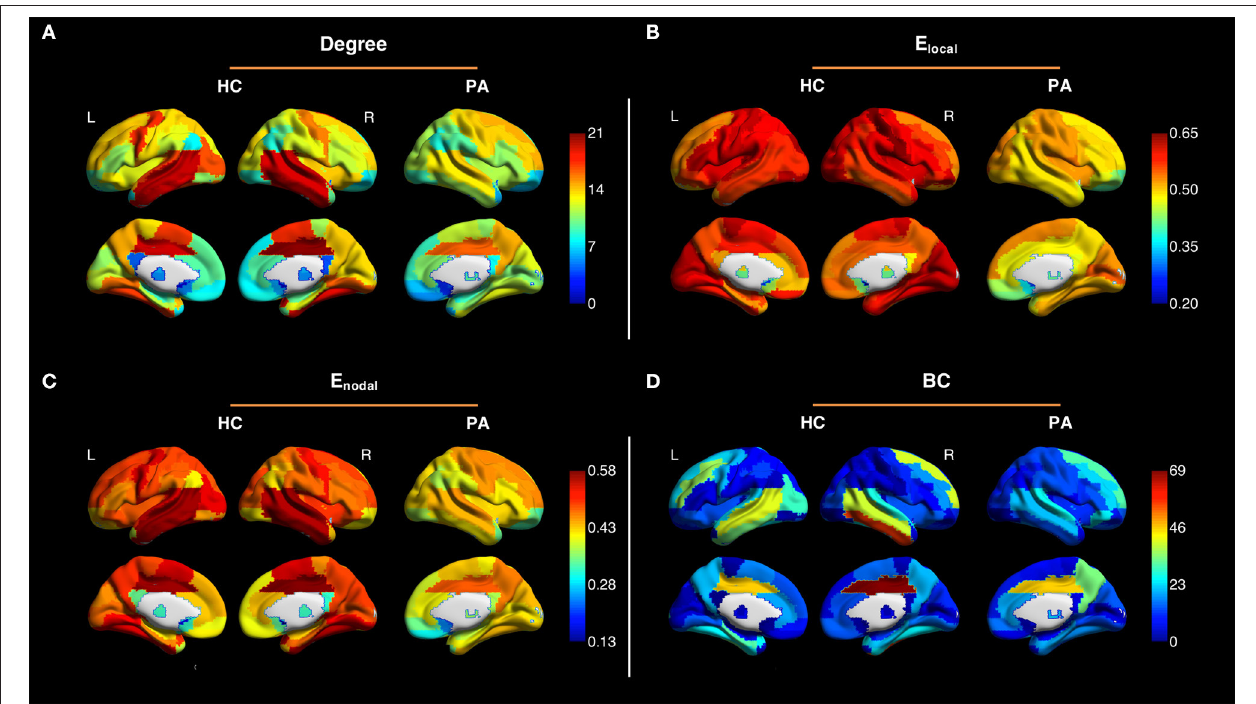
FIGURE 2 | Averaged maps of degree (A) , local efficiency E local (B) , nodal efficiency E nodal (C) , and betweenness centrality (BC) (D) in the left and right hemispheres of the healthy controls (HC) and in the contralateral hemispheres of the patients (PA) (connectivity sparsity = 40%). The maps of the patients with right-sided disease were left-right flipped to create the averaged maps. Overall, degree, E local and E nodal were lower in the patients as compared to the healthy controls.